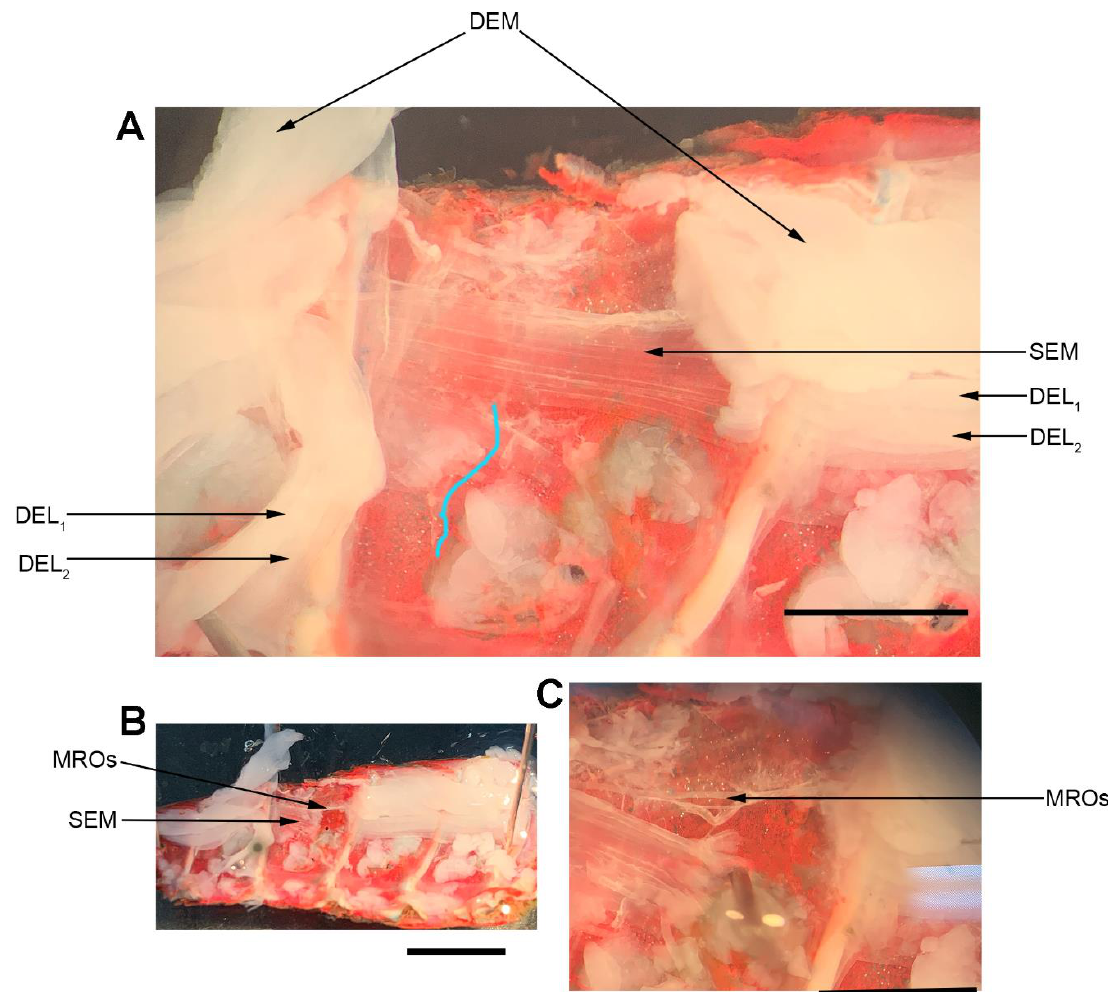
Figure 3. Location of the muscle receptor organ (MRO). ( A ) A hemi-section of the crayfish abdomen viewed from ventral to dorsal after removal of the ventral muscle. The DEM muscle is cut on the right side of figure and pulled to left. The segmental nerve containing the nerves associated with the MRO was taken up by a suction electrode (the blue line outline is the segmental nerve). The deep extensor muscles (DEL1, DEL2, and DEM) and the superficial extensor medial muscle (SEM) are shown. The MRO organ is beneath the DEL1 muscle alongside to the DEM. ( B ) The superficial extensor medial muscle (SEM) was cut on the right side in the figure to expose the two MRO muscles. ( C ) The two MRO muscle fibers are shown with the nerve bundle pulling the fiber toward the SEM muscle. Scale bar: A and C is 2.5 mm; B is 5 mm.